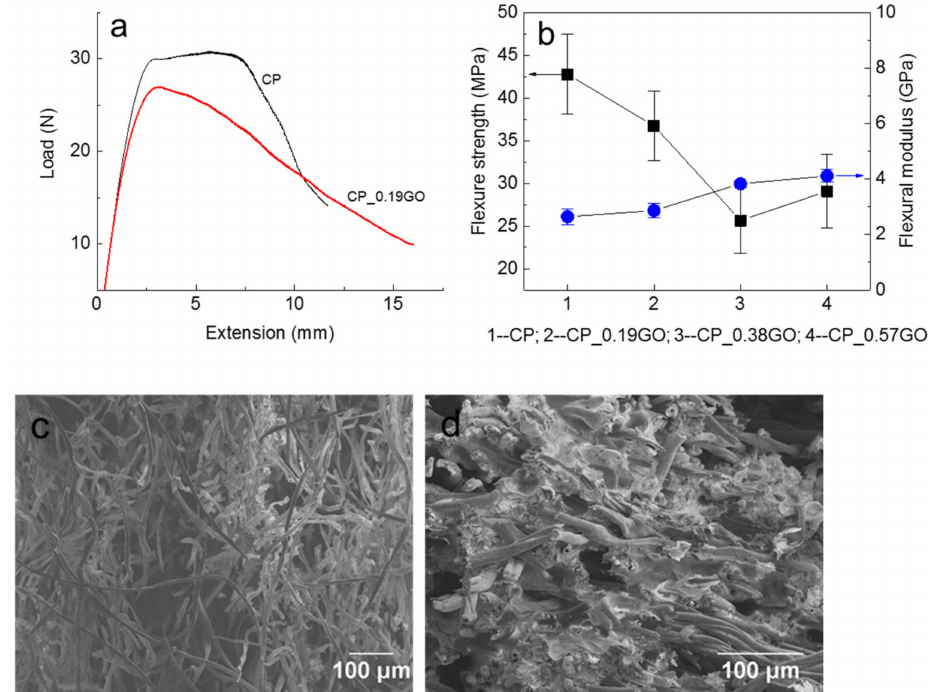
Figure 7. Three-point bending properties and fracture surface of the cotton/PLA composites. ( a ) The typical loading curves for the cotton/PLA composite and the GNP coated composite; ( b ) the flex- ural strength and modulus for each composite type; ( c , d ) flexural fracture surfaces of CP and CP_0.38GO, respectively.